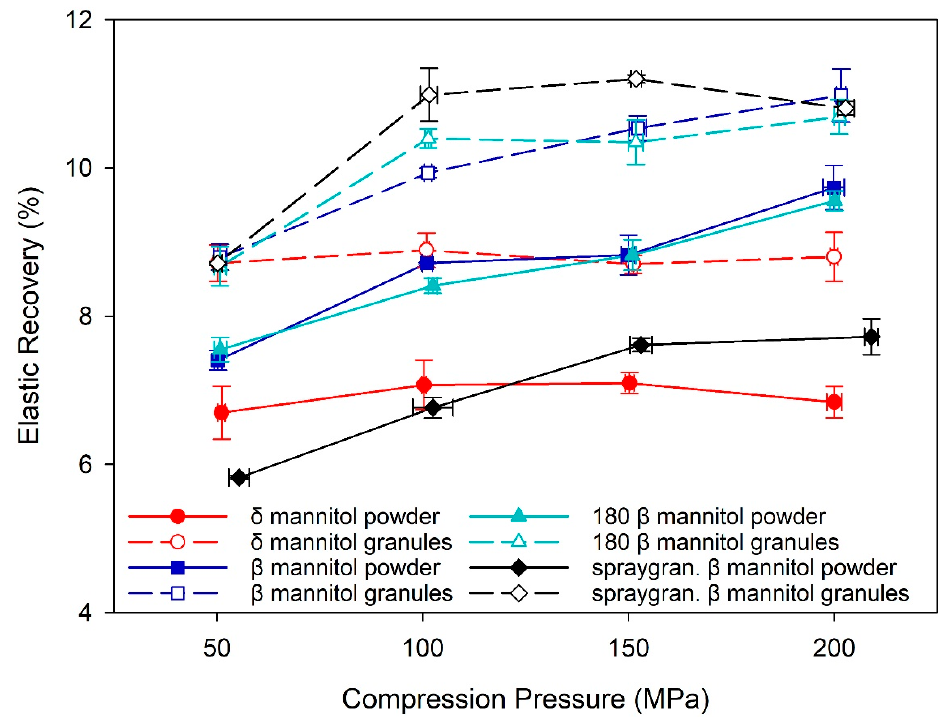
= 10 ± S.D. n = 10 ± S.D.